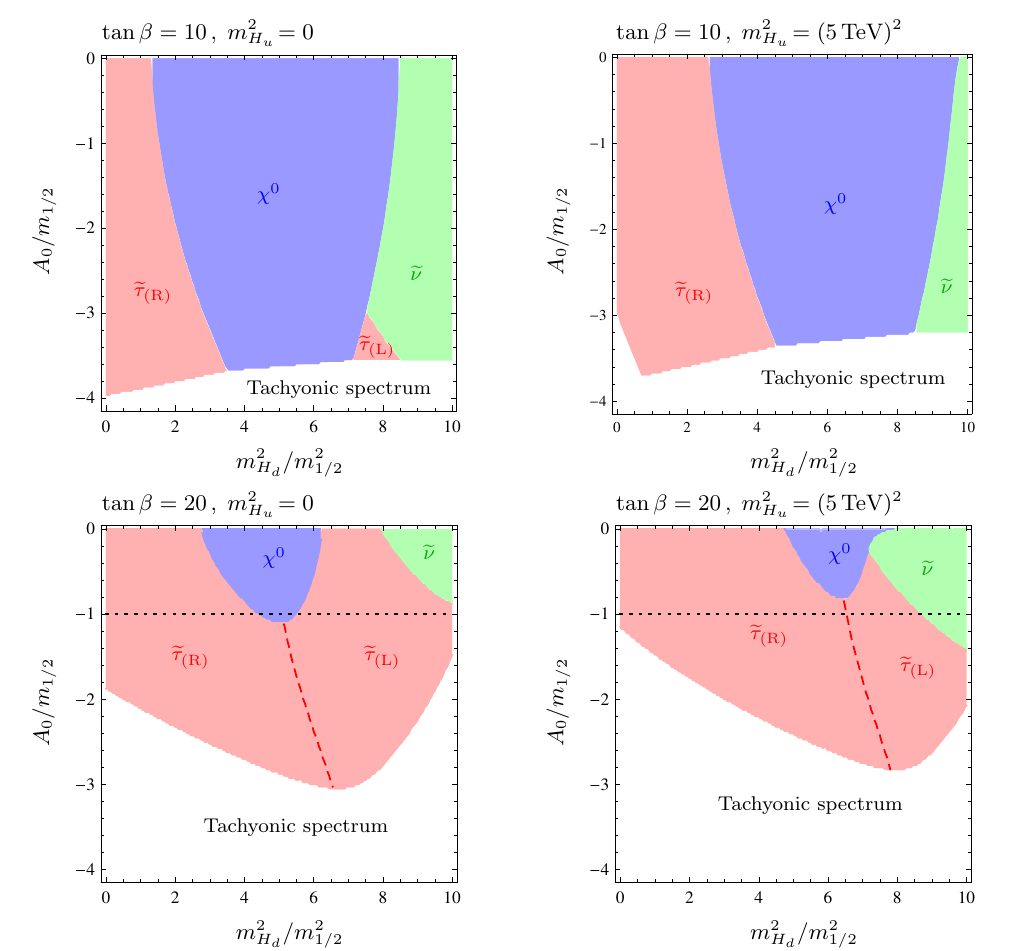
Figure 2 . Regions characterized by a stau (red), neutralino (blue) and sneutrino (green) NLSP in the m 2 =m 2 - A 0 =m plane for four choices of tan (cid:12) and m 2 1 = 2 H d 1 = 2 the white region below, we run into a tachyonic region, i.e., negative soft masses squared. The red dashed curve indicates the transition from a predominantly right- to left-handed stau NLSP, i.e., the contour sin 2 (cid:18) (cid:28) = 1 = 2. The black dotted lines in the lower plots denote the slices in parameter space that are considered in (cid:12)gure